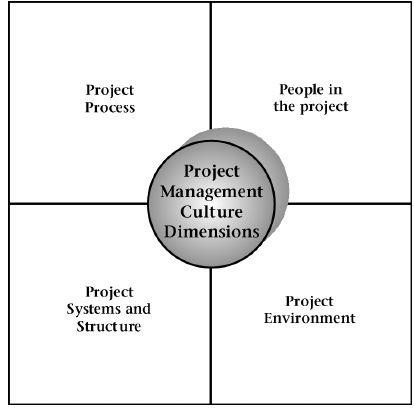
Figure 1: Project Management Culture